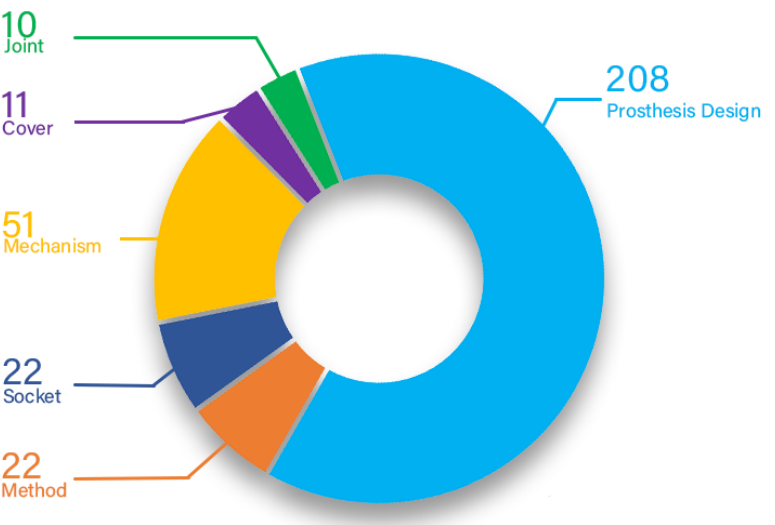
Figure 3. Categories of the patents’ analysis and results by category.